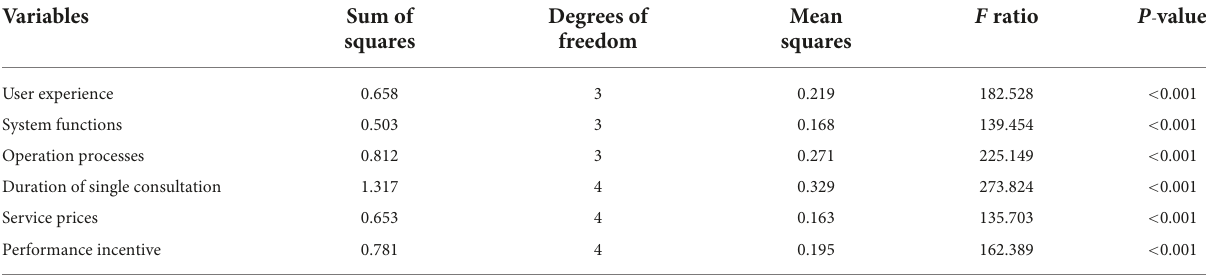
TABLE 5 Multivariate analysis of factors influencing pediatricians’ satisfaction with internet